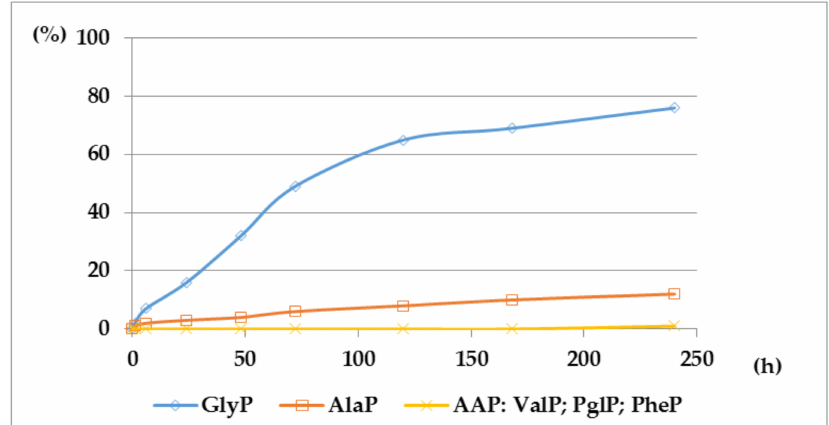
Figure 4. A solution of 0.1 M 1-(acetylamino)alkylphosphonic acids Ac-AA P in 2 M KOH reacted at